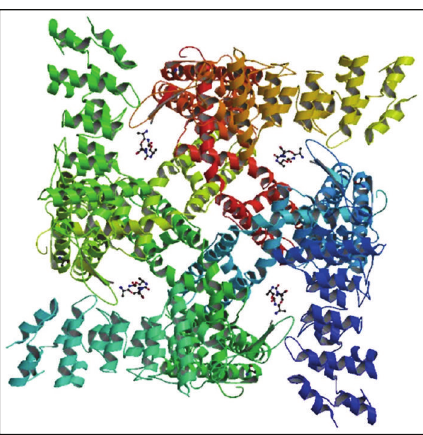
Figure 3: Reconstruction of homotetrameric rodent TRPV1 ion channel complexed with capsaicin that was obtained by single particle electron cryomicroscopy. Image from PDB ID 3J5R. Liao et al. [43] (http://www.rcsb.org/